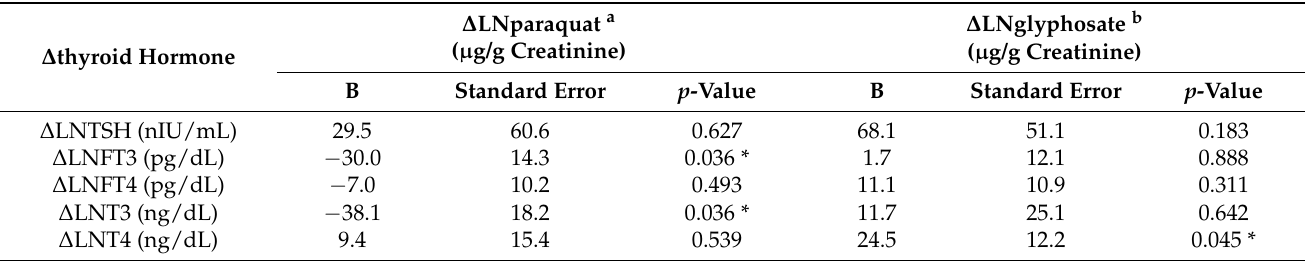
Table 9. Model for change in thyroid hormone levels (logged morning after spraying—logged morning before spraying) as a function of the change in urinary metabolite levels for sprayed herbicides paraquat or glyphosate (logged morning after spraying—logged morning before